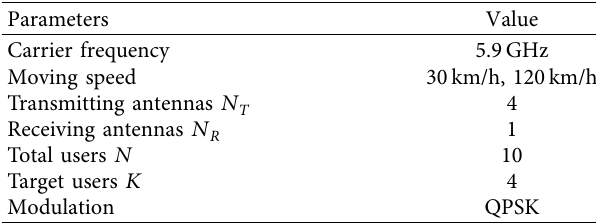
Table 2: Simulation